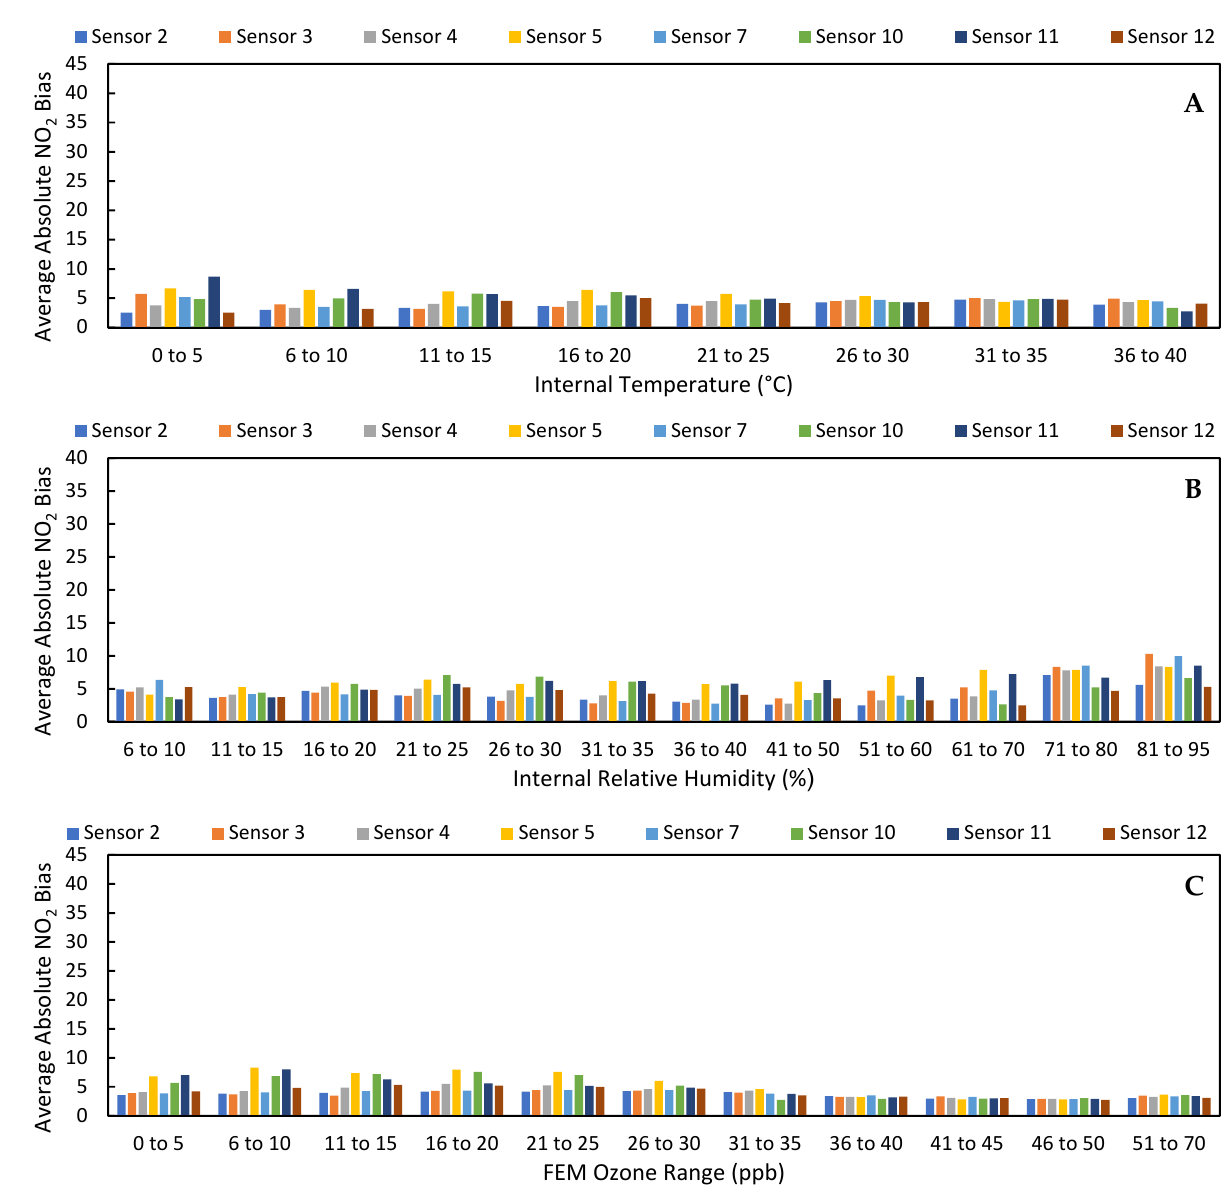
Figure 13 . ( A ) The average absolute bias of the Ozone corrected 30-day LCS NO 2 data binned by internal temperature values. ( B ) The average absolute bias of the raw LCS NO 2 data binned by internal relative humidity values. ( C ) The average absolute bias of the raw LCS NO 2 data binned by West Phoenix FEM O 3 values.